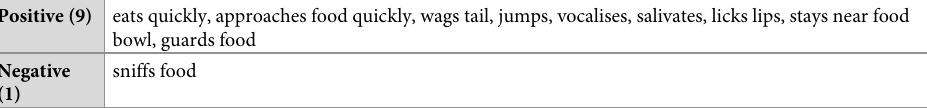
Table 1. Behavioural indicators of positive or negative palatability in 2,308 sampled dogs. Positive (9) eats quickly, approaches food quickly, wags tail, jumps, vocalises, salivates, licks lips, stays near food bowl, guards